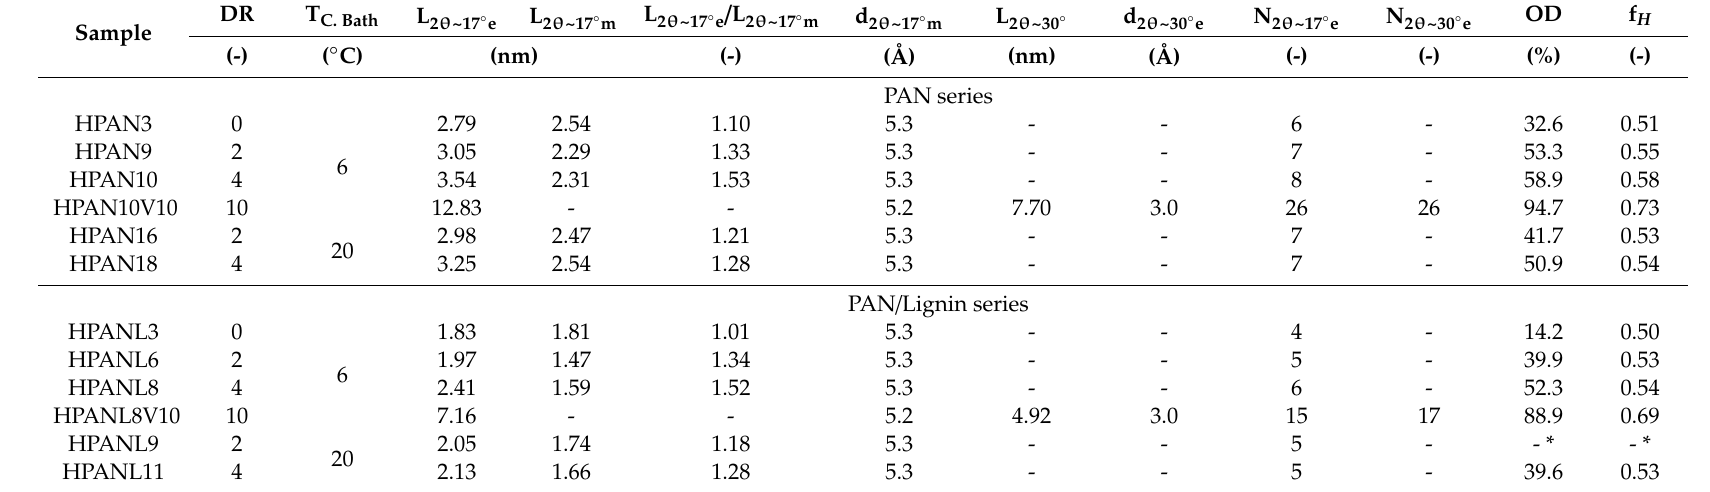
Table 4. Crystal structure parameters of the PAN-fibers and PAN / lignin